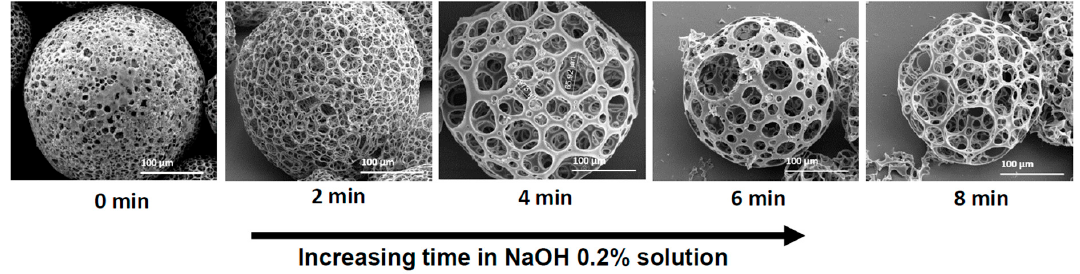
Figure 7. SEM images of 3% ( w / v ) PLGA 75:25 porous microspheres obtained by the microfluidic technique at increasing soaking time in NaOH 0.2% solution. As immersion time increased, a more porous structure was obtained.